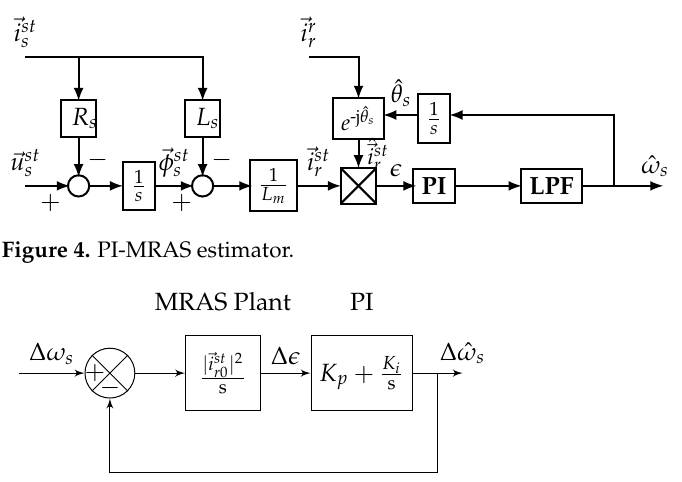
Figure 5. PI-MRAS closed-loop diagram using the small signal